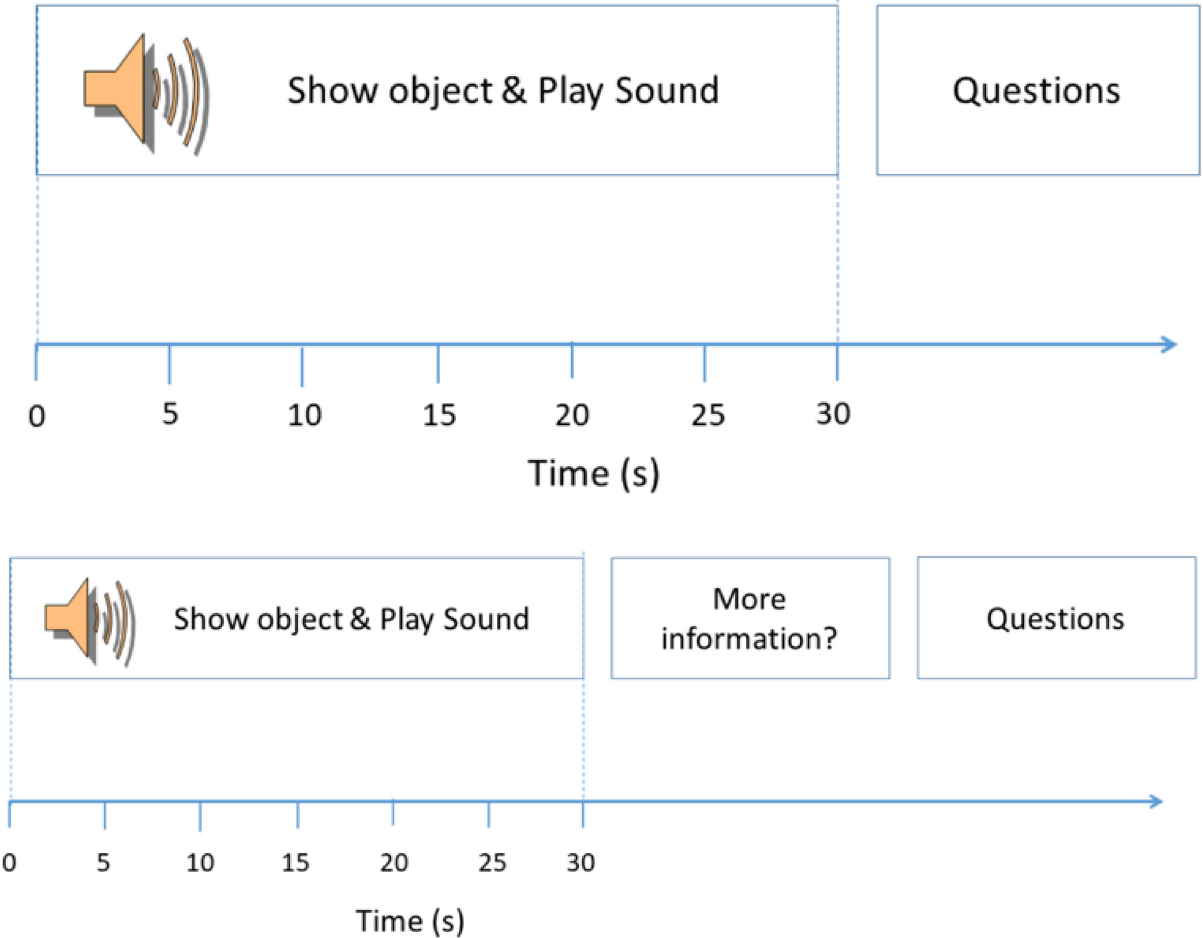
Fig 1. Timing of events within the two types of trial used in the experiment. Trial type A (top plot) presents soundscapes and objects for 30s before asking participants to report their felt affect and engagement. Trial type B (bottom plot) also presents the objects and soundscapes for 30s before asking the participants if they want more information and then asking participants to report their felt affect and engagement.